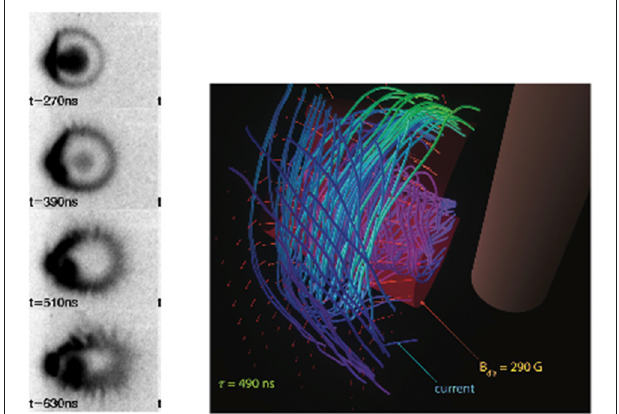
FIGURE 7 | Results of the laser experiment by Collette and Gekelman (2011) showing: [left] series of high resolution photos at various times showing development of small-scale flute models on the expanding plasma shell; [right] composite of magnetic field probe measurements to show the magnetic field lines (blue) and azimuthal current structure (red) around the expanding shell (the brown cylinder to the right represents the target). The left panels are from Figure 2, the right panel from Figure 6 in Collette and Gekelman (2011) , reproduced with permission from The American Institute of